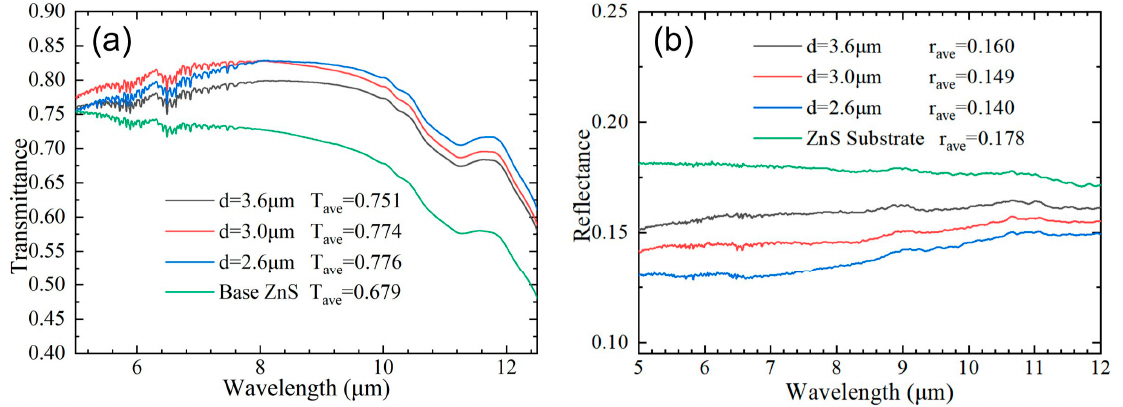
Figure 4. Measured infrared transmittance ( a ) and reflectance ( b ) spectra of ASS fabricated by 20× microscope objective Bessel beam.